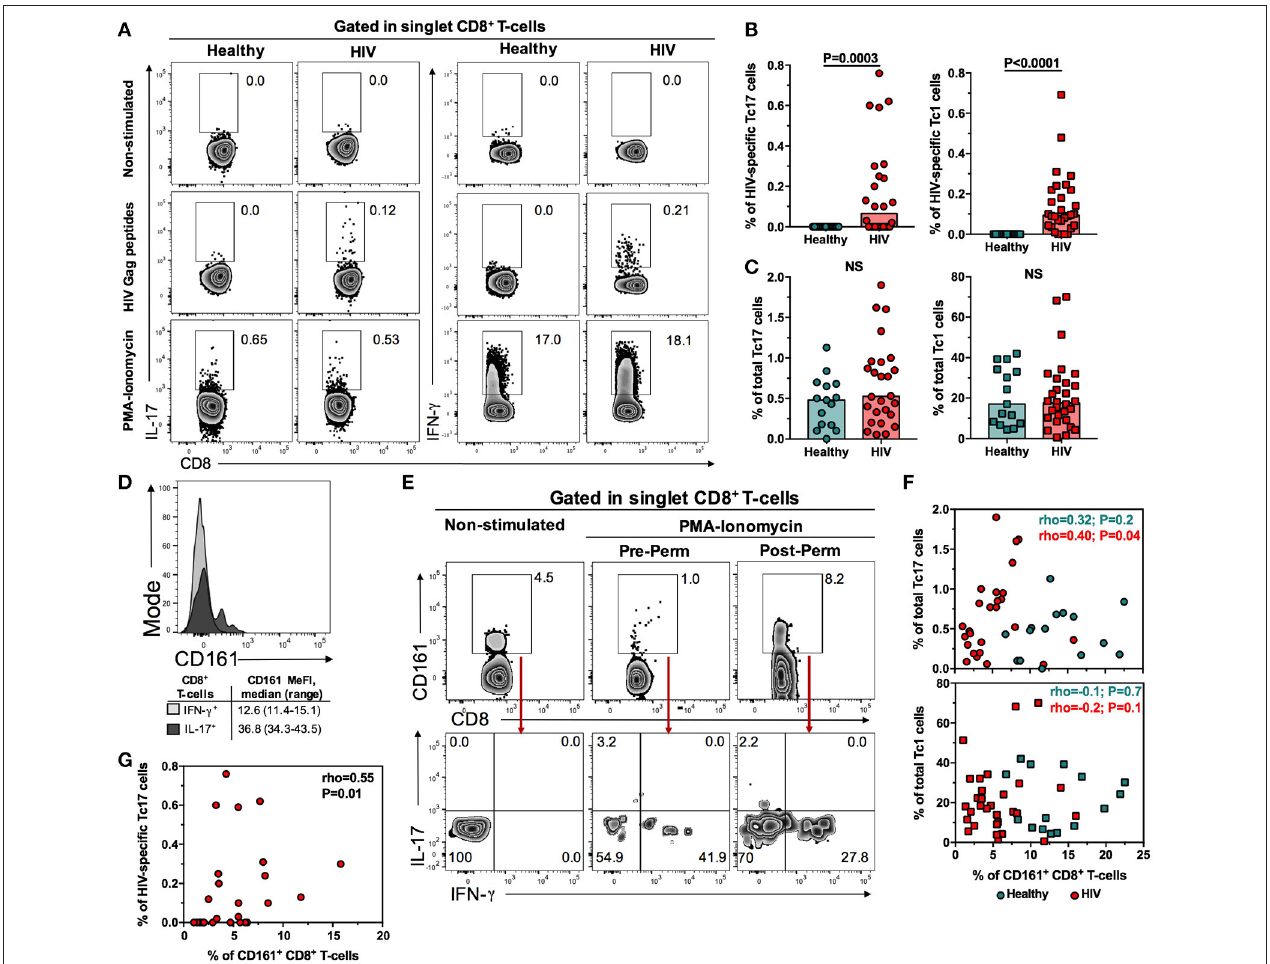
FIGURE 2 | Conserved frequency of total Tc17 cells in PLWH on suppressive HAART. (A) Gating strategy for the detection of total and HIV-specific Tc17 and Tc1 cells. Representative zebra plots from non-stimulated, HIV Gag peptides- and PMA-ionomycin-treated cells from a healthy individual and a subject living with HIV are shown. After duplicates exclusion (FSC-A/FSC-H), CD8 + T-cells were identified as CD3 + CD8 + cells. The numbers next to the gates indicate the percentage of the population. (B) Frequency of HIV-specific Tc17 and Tc1 cells in healthy individuals and PLWH. (C) Frequency of total Tc17 and Tc1 cells in healthy individuals and PLWH. (D) Representative expression of CD161 in IL-17 + and IFN- γ + CD8 + T-cells from a healthy individual, after PMA-ionomycin stimulation. The summary of the median fluorescence intensity (MeFI) of the populations is shown below. (E) Gating strategy for the detection, after cell culture, of IL-17- and IFN- γ -producing CD161-expressing CD8 + T-cells from a subject living with HIV. In the left zebra plots are shown non-stimulated cells. In the middle and right zebra plots are shown PMA-ionomycin-stimulated cells where the anti-CD161 antibody was added before (middle panels) or after (right panels) cell permeabilization. The numbers indicate the percentage of the populations. (F) Correlation between the frequency of total Tc17 (upper panel) and Tc1 (lower panel) cells and the frequency of circulating CD161 + CD8 + T-cells in healthy individuals and PLWH. (G) Correlation between the frequency of HIV-specific Tc17 cells and the frequency of circulating CD161 + CD8 + T-cells in PLWH. In (G,H) the rho and P value of the Spearman test are shown. NS, Not statistically significant.